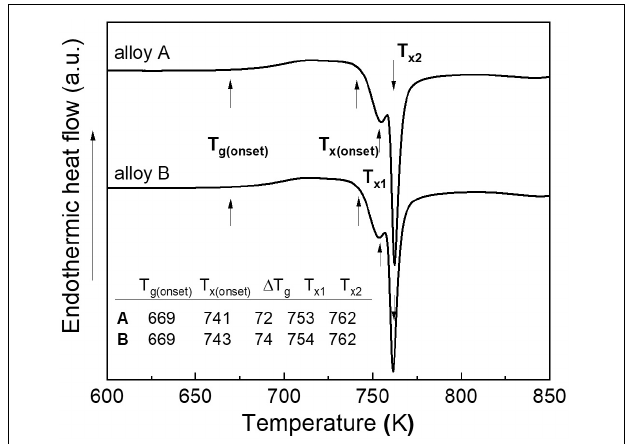
FIGURE 3 | Differential scanning calorimetry (DSC) curves of Vit 105 bulk metallic glass (BMG) samples of types A and B recorded at a heating rate of 40